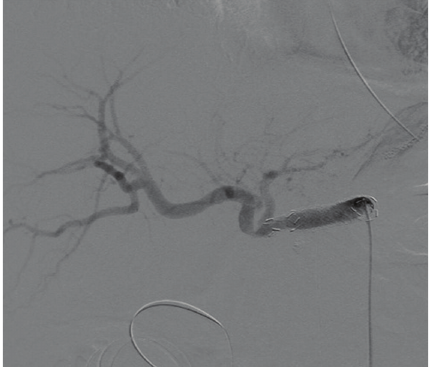
Figure4:Angiographyshowssuccessfulplacementofthestentgraft at the inside of the initial stent graft to the distal